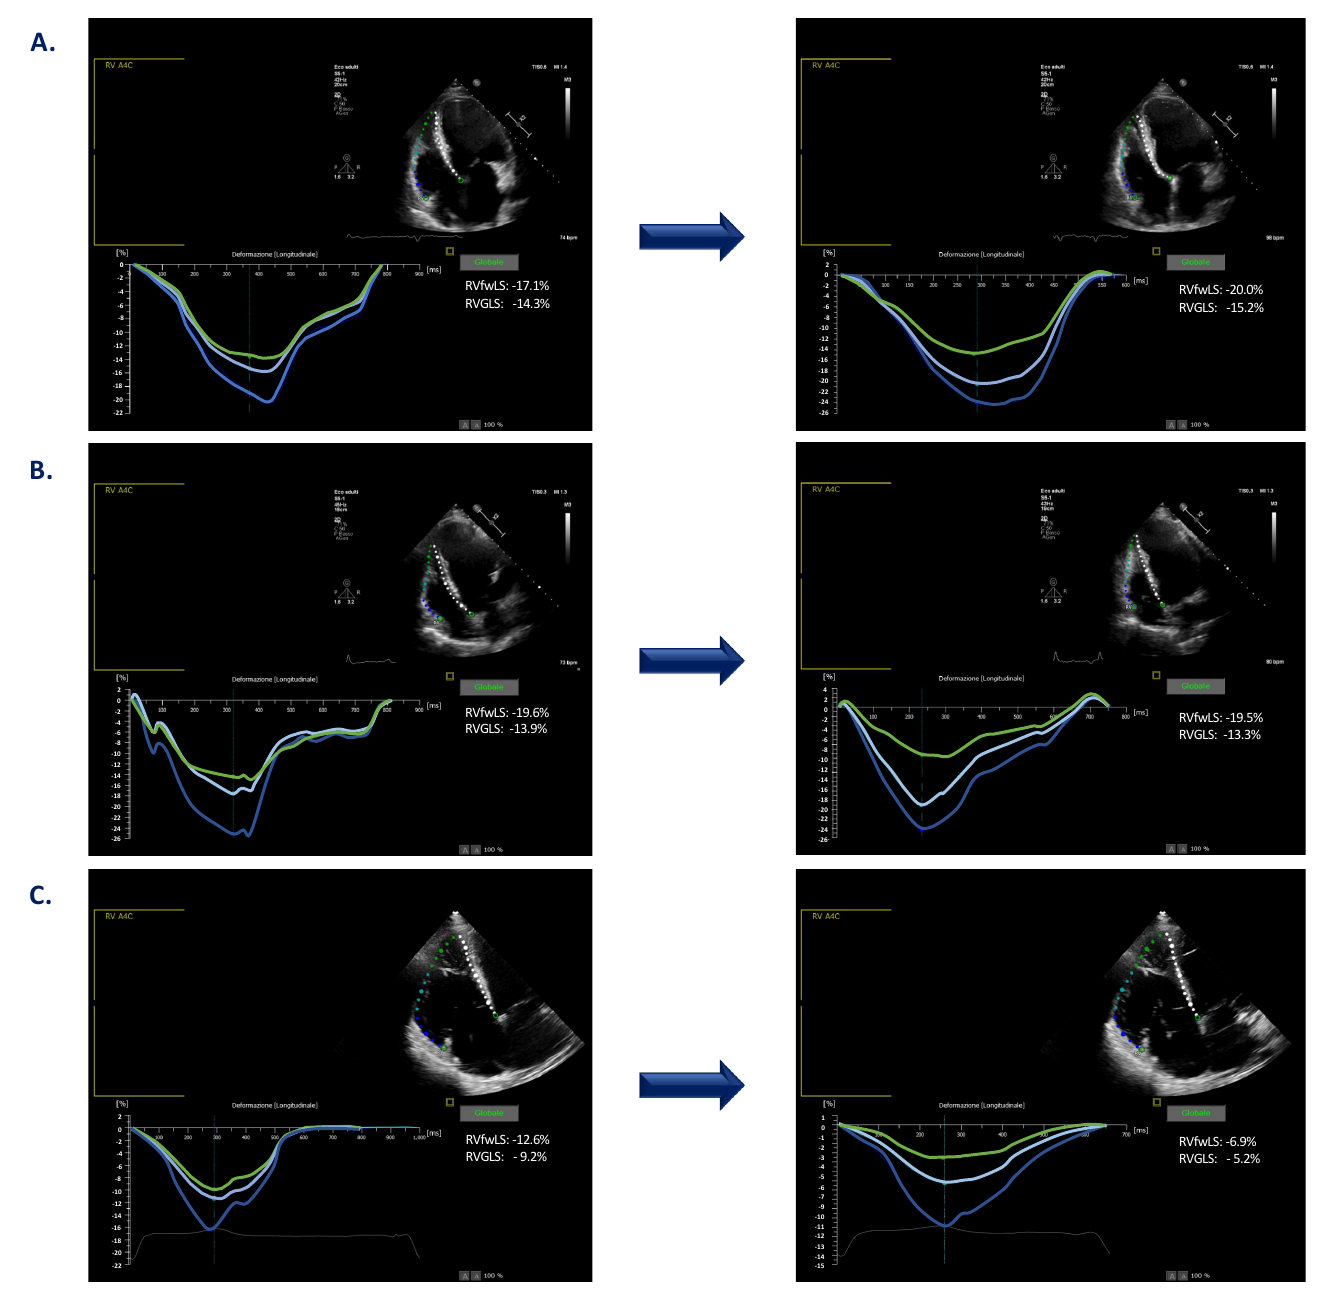
Figure 3. Three examples of changes in RVGLS. The example in ( A ) documents improved RVGLS with increasing HR. The examples in ( B , C ) document no changes and deterioration in RVGLS, respectively, in response to increasing HR. Note that the scale of left and right panels automatically changes according to the strain values